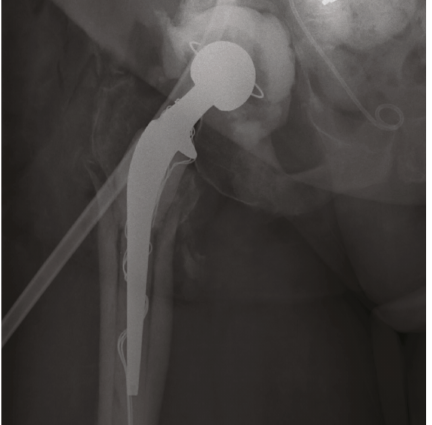
Figure 8: XR right hip. Stage 2: temporary